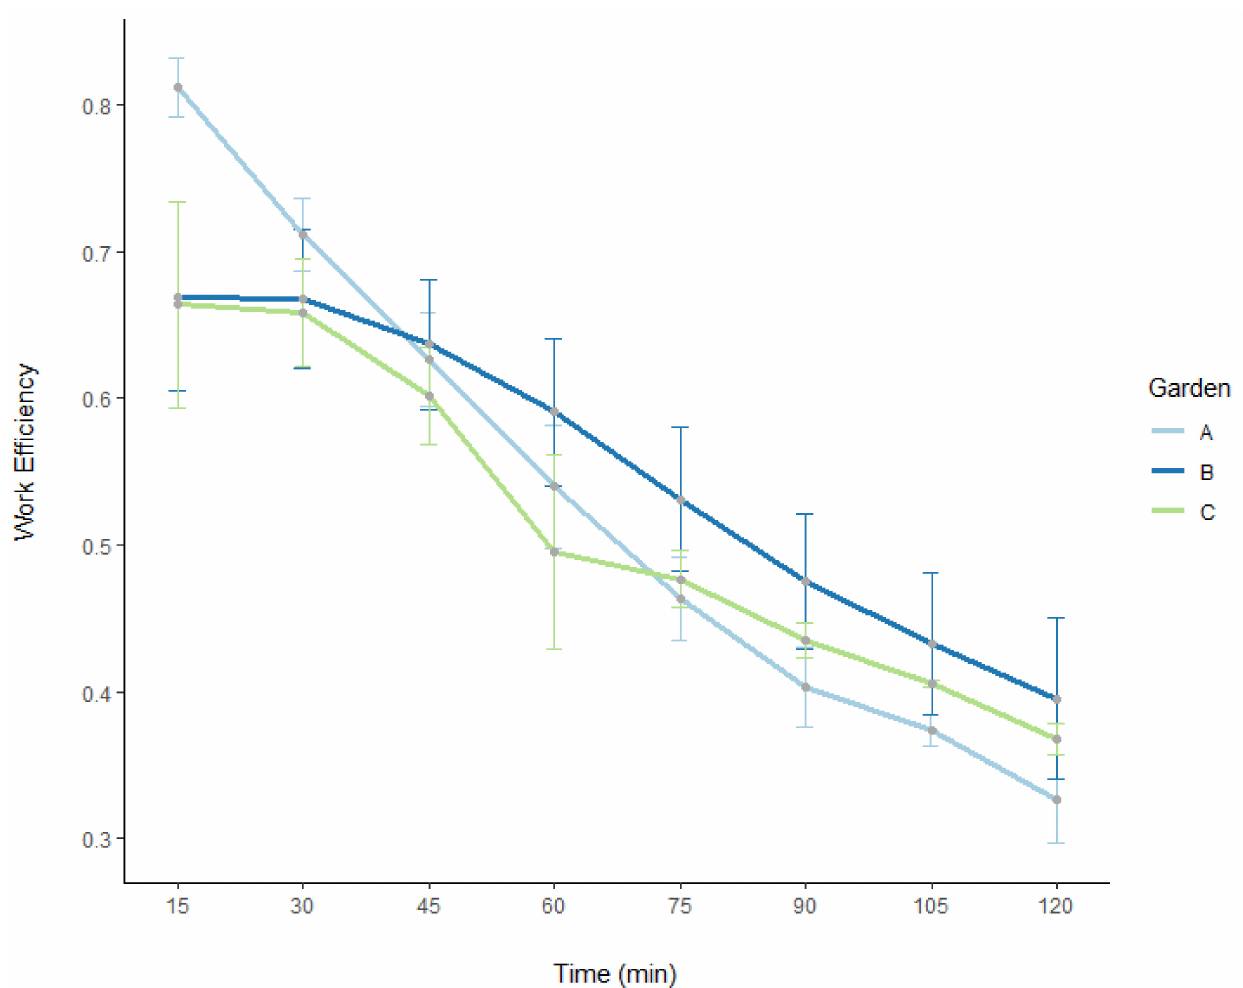
Figure 7. Back-transformed values of working efficiency in function of garden typologies and time intervals. Vertical bars represent the standard errors (A = no obstacles, B = low level of complexity, C = high level of